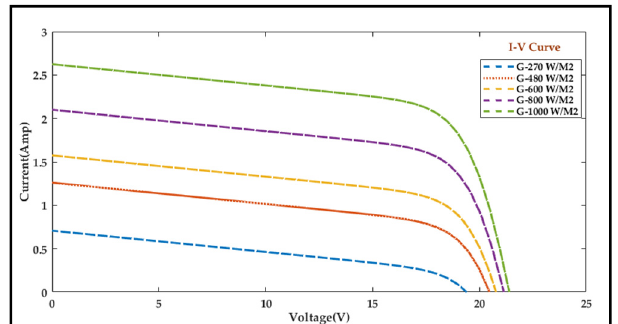
Figure 6. I-V curve of PV panel. 2.15 amp, Vmp = 17.5 volt, Imp = 1.75 amp as shown in Figure 7.